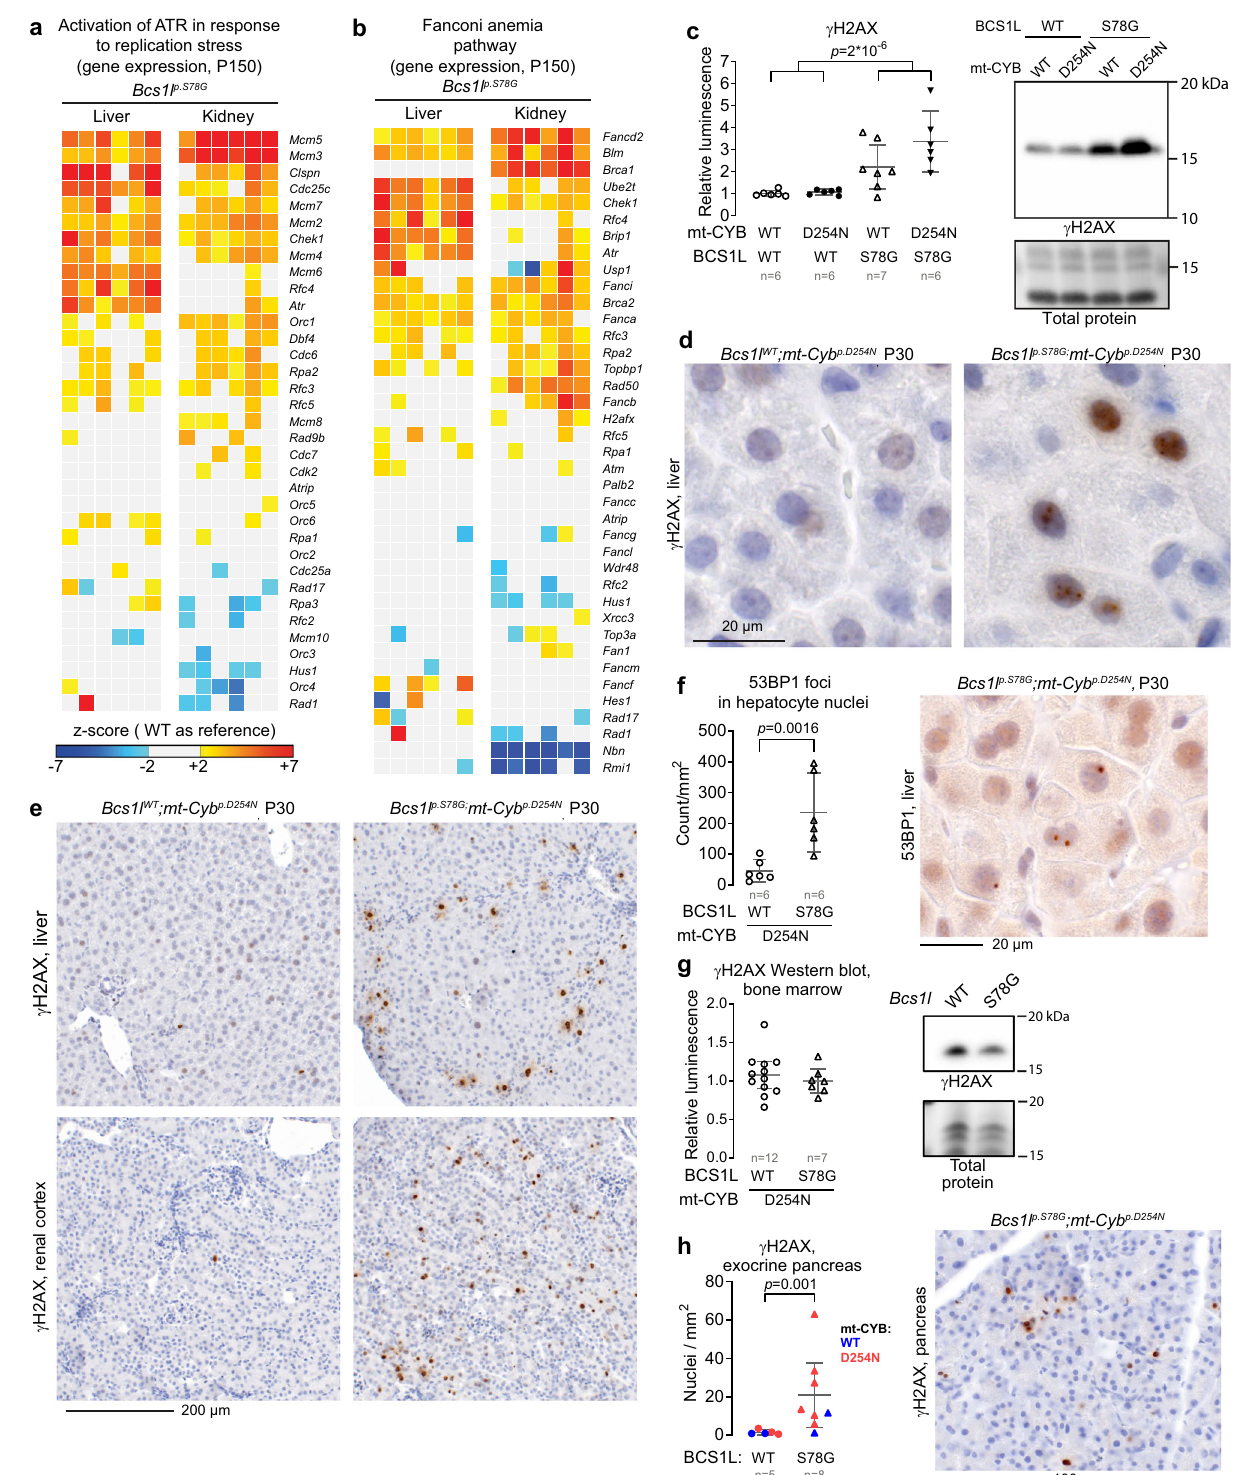
Fig.2|NuclearDNAdamageinCIII-de fi cientmice.a , b Heatmapvisualizationof liver and kidney transcriptomics data overlapping with “ activation of ATR in response to replication stress ” ( a ) and “ Fanconi anemia ” ( b ) pathways (Reactome database). c Westernblotquanti fi cationandrepresentativeblotof γ H2AXfromP30 liver lysates as a marker for DNA double-strand breaks. d , e γ H2AX